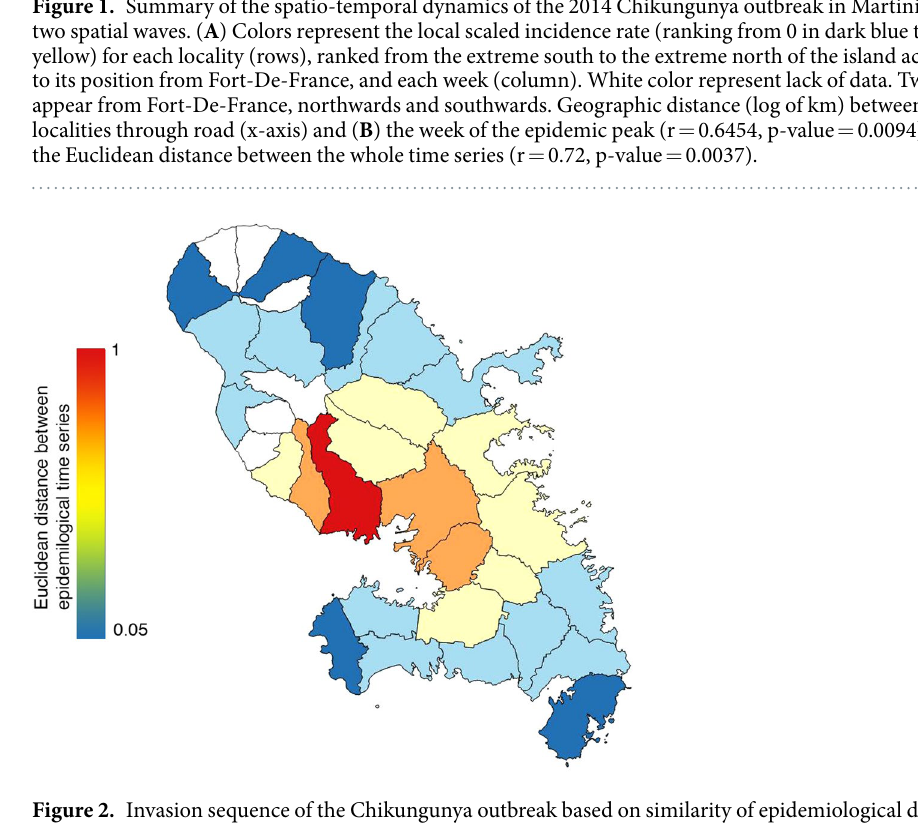
the whole series (r = 0.49, p-value = 0.061), while in the south of the island, it likely relied on the whole times series (r = 0.72, p-value = 0.0037) rather than on the epidemic peak (r = 0.39, p-value = 0.16). Based on these correlations, we used the correlation coefficients to characterize the invasion sequence of the virus throughout the island (Fig. 2). In order to focus on a time period when pathogen dispersal was limited, we limited the analysis of the island temporal dynamics to the time period before it began spreading to remote areas within the island, i . e . from December 2013 to May 2014. We estimated parameters x 1 , x 2 and x 3 for all possible combinations of transmis- sion drivers (mosquito abundance, awareness of the epidemic, and the need for protection) and an anticipated